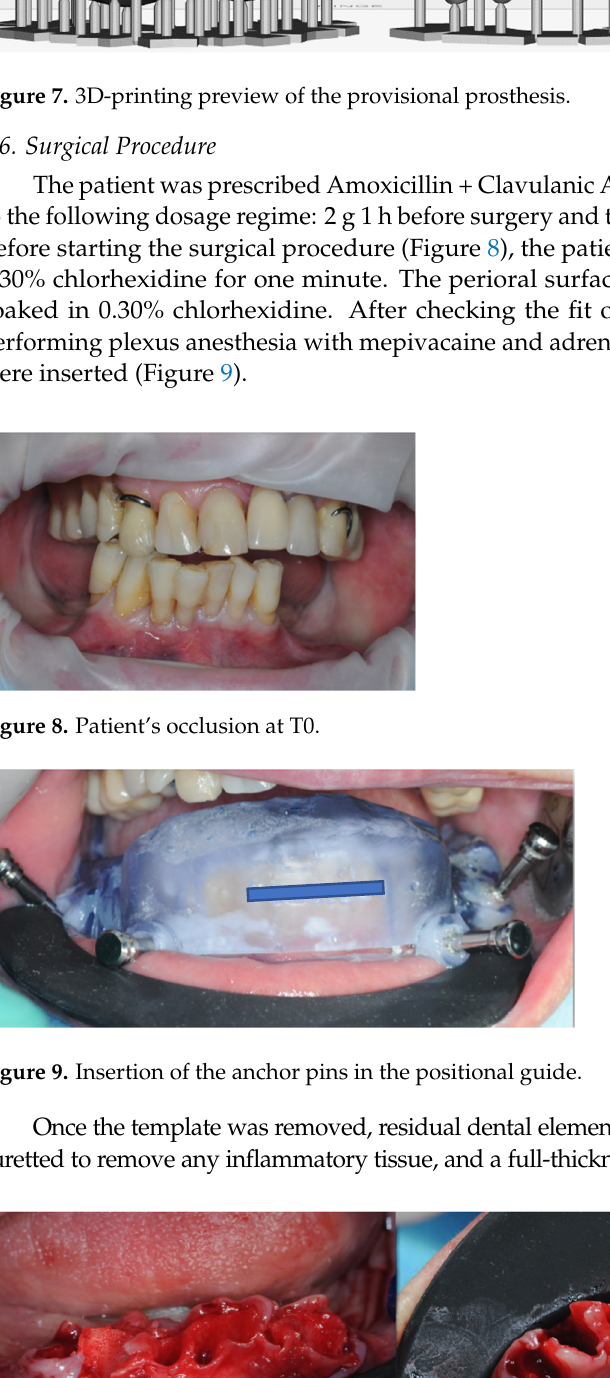
7 Figure 5. ( a ) Osteotomic and positional guide; ( b , c ) implant Guide in sagittal and coronal view. Figure 6. 3D-printing preview of the guides. 4.5. Prosthesis Once the design of the surgical guides was completed and the extent of the osteotomy was established, it was possible to design the gingival part of the temporary prosthesis. The main focus was to give the metal-free prothesis adequate thickness to guarantee the